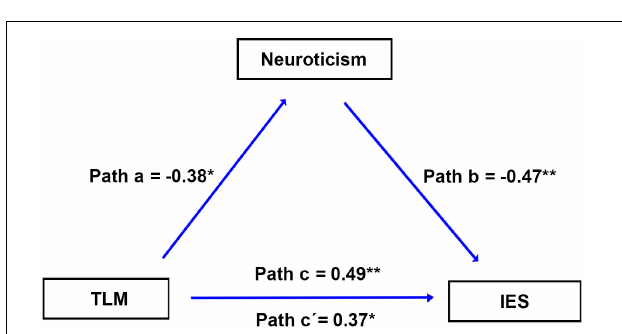
FIGURE 4 | Results of the mediation analysis. Neuroticism mediates the association between the brain structure and IES. Paths a, b, c, and c’ denote standard regression coefficients. Path a: rGMV in the TLM.L is significantly correlated with neuroticism. Path b: neuroticism is significantly correlated with IES. Path c: rGMV in the TLM.L is significantly correlated with IES. Path c’: after regressing out neuroticism, rGMV in the TLM.L is significantly correlated with IES. IES, inverse efficiency score; rGMV, regional gray matter volume; TLM.L, left